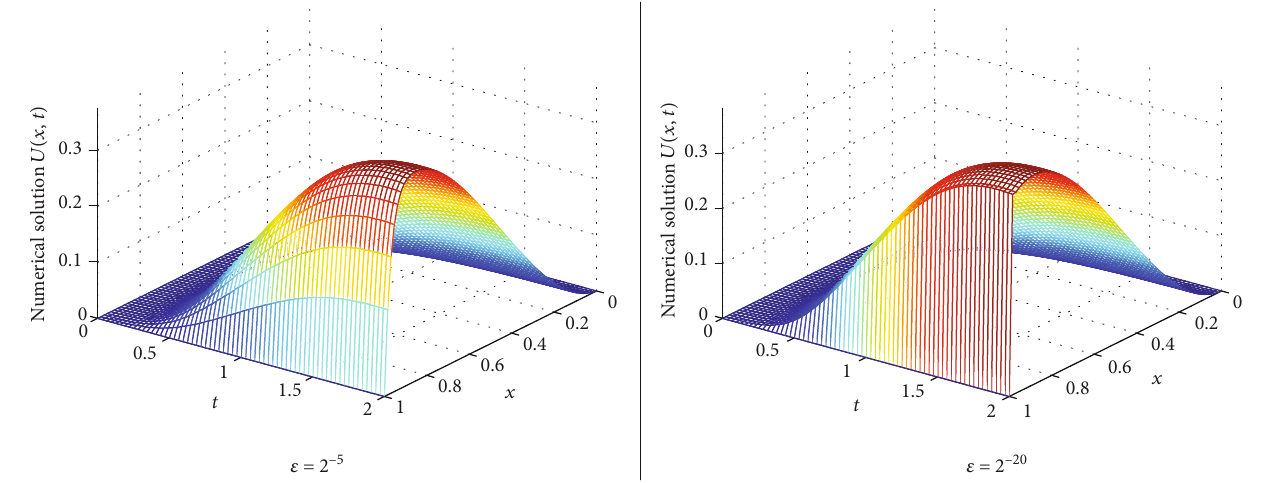
Figure 1: Solution of Example 19, with boundary layer formation.